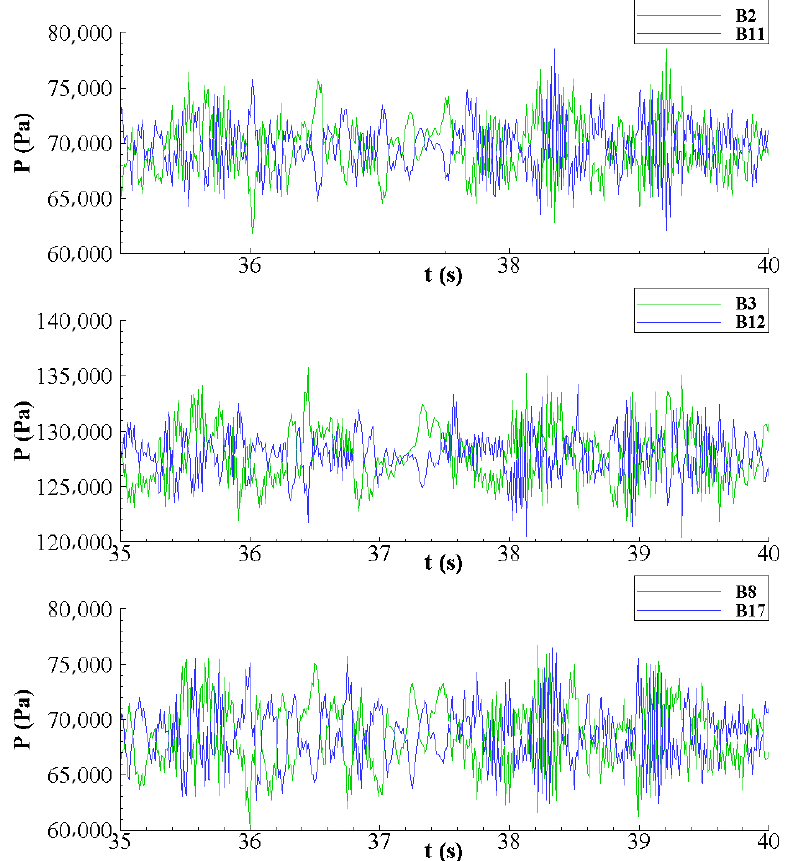
Figure 13. Comparison of pressure evolution at the symmetrical boundary points. (Wenchuan EW excitation).